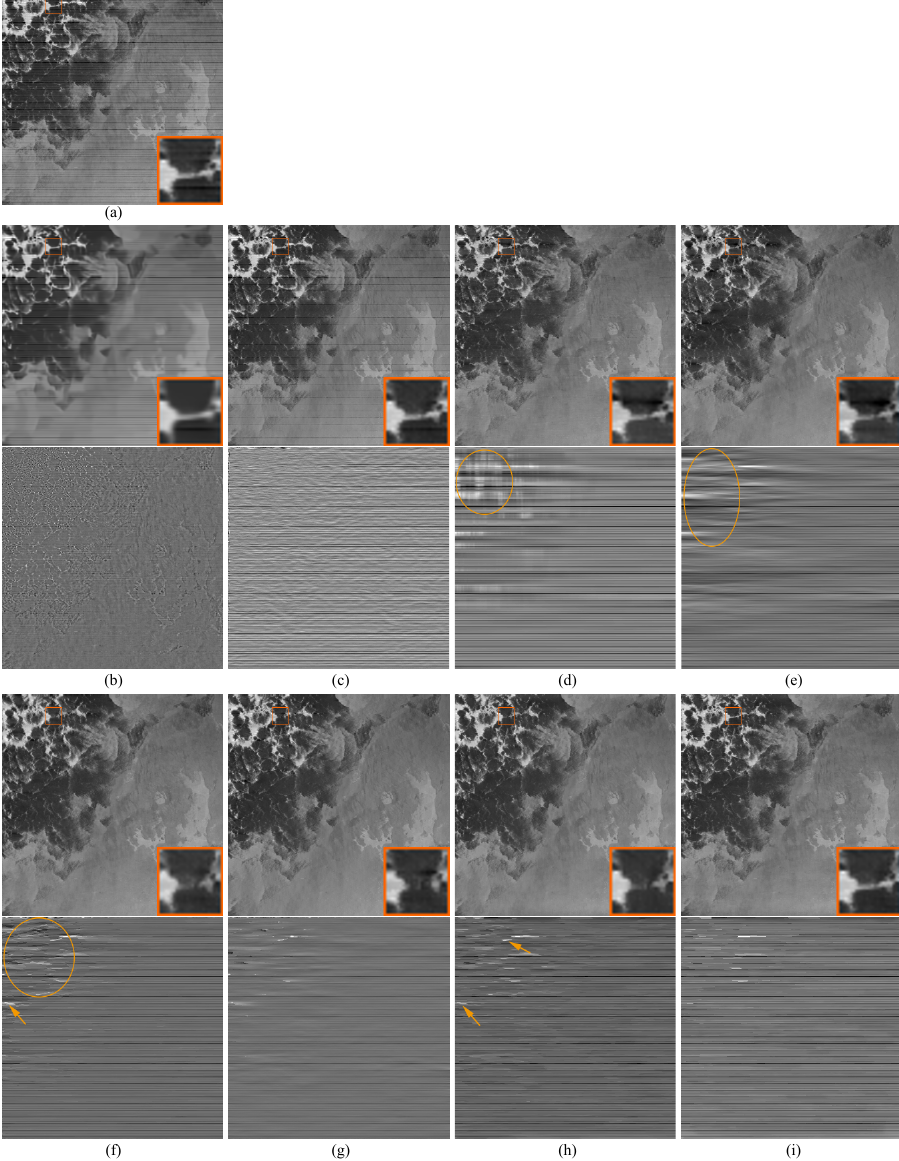
Figure 19. Results of different methods on Terra MODIS data band 30 R3. ( a ) original; ( b ) BM3D; ( c ) SNRCNN; ( d ) GF-based; ( e ) WAFT; ( f ) UV; ( g ) HUTV; ( h ) SUV; ( i ) WDSUV. Zoom in for better visualization. In each result, the top part is the destriping result, and the bottom part is the corresponding stripe noise